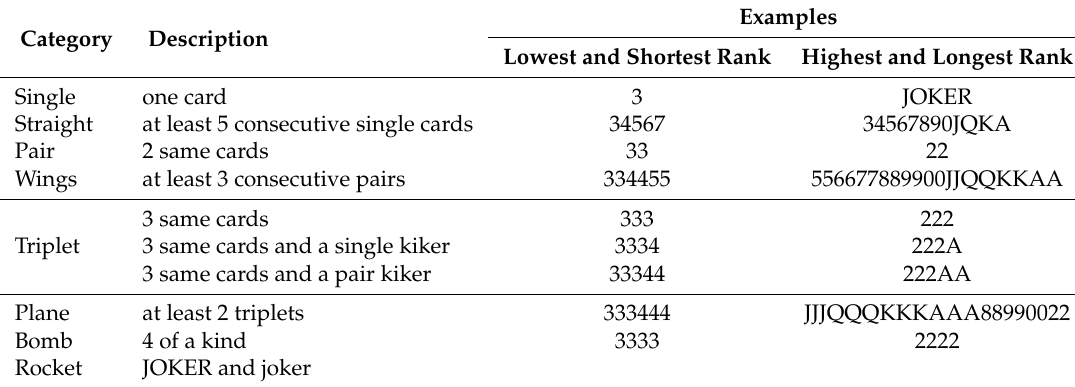
Table 2. Categories of cards.